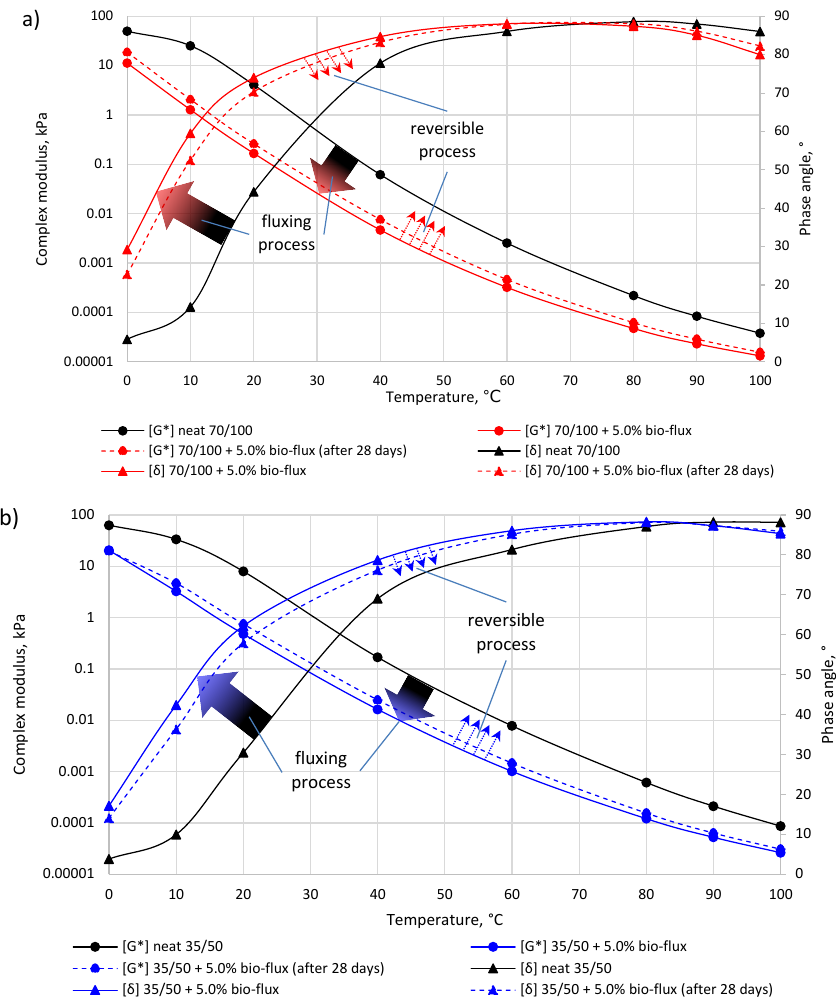
Figure 6. Fluxing and reversibility processes of bio-fluxed bitumen based on the dynamic shear test: ( a ) 70/100 bitumen; and ( b ) 35/50 bitumen.